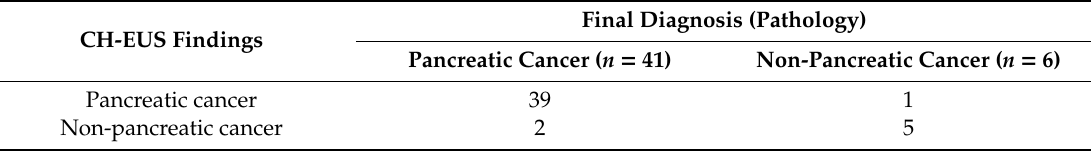
Table 3. Diagnostic ability of CH-EUS for pancreatic lesions measuring 11–20